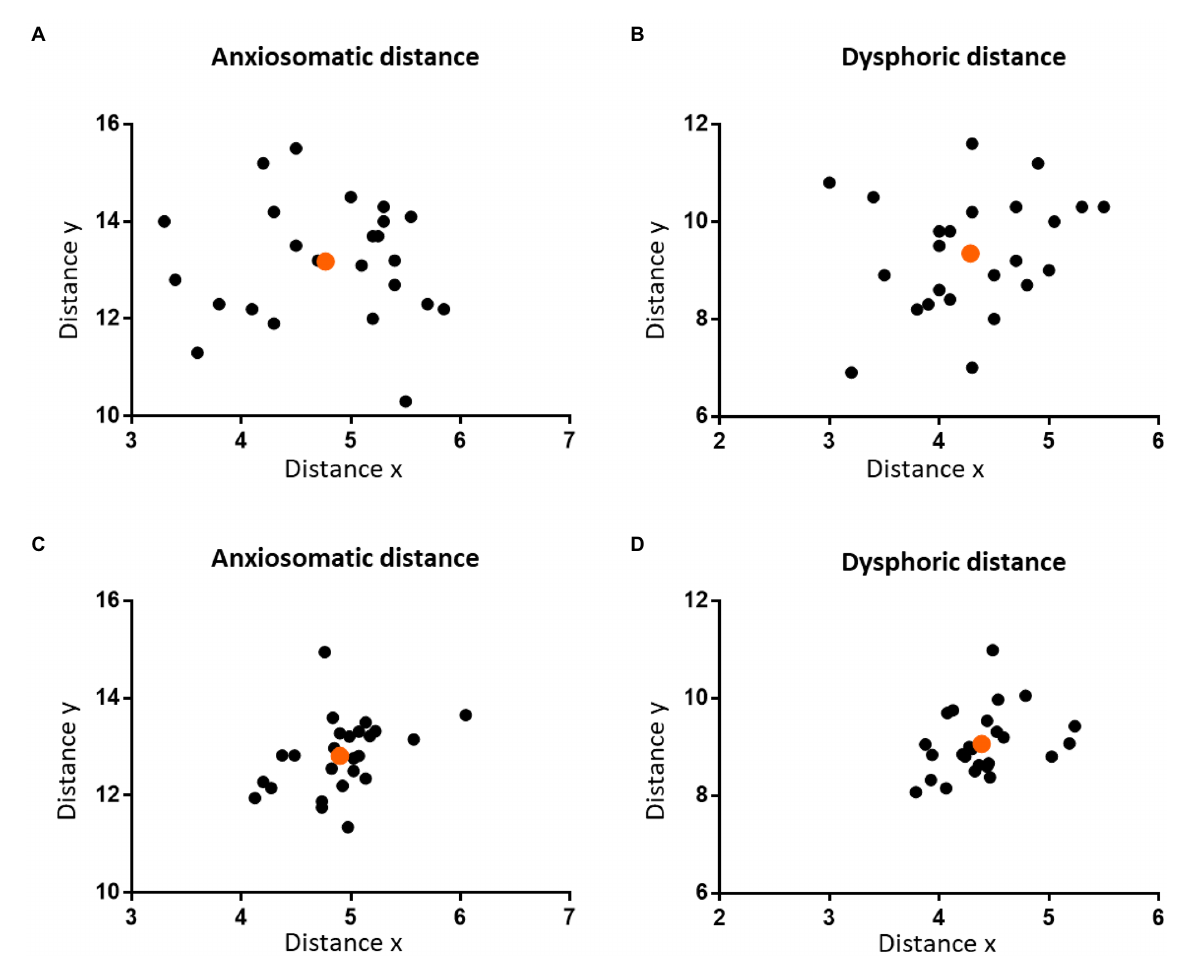
FIGURE 2 The distribution of the personalized targets on the scalp. The two figures in the upper panel show the distribution of the personalized anxiosomatic targets (A) and personalized dysphoric targets (B) on the scalp in discovery cohort, respectively. The two figures on the lower panel show the distribution of the personalized anxiosomatic targets (C) and personalized dysphoric targets (D) in the validation cohort, respectively. The mean position of each cohort is marked in